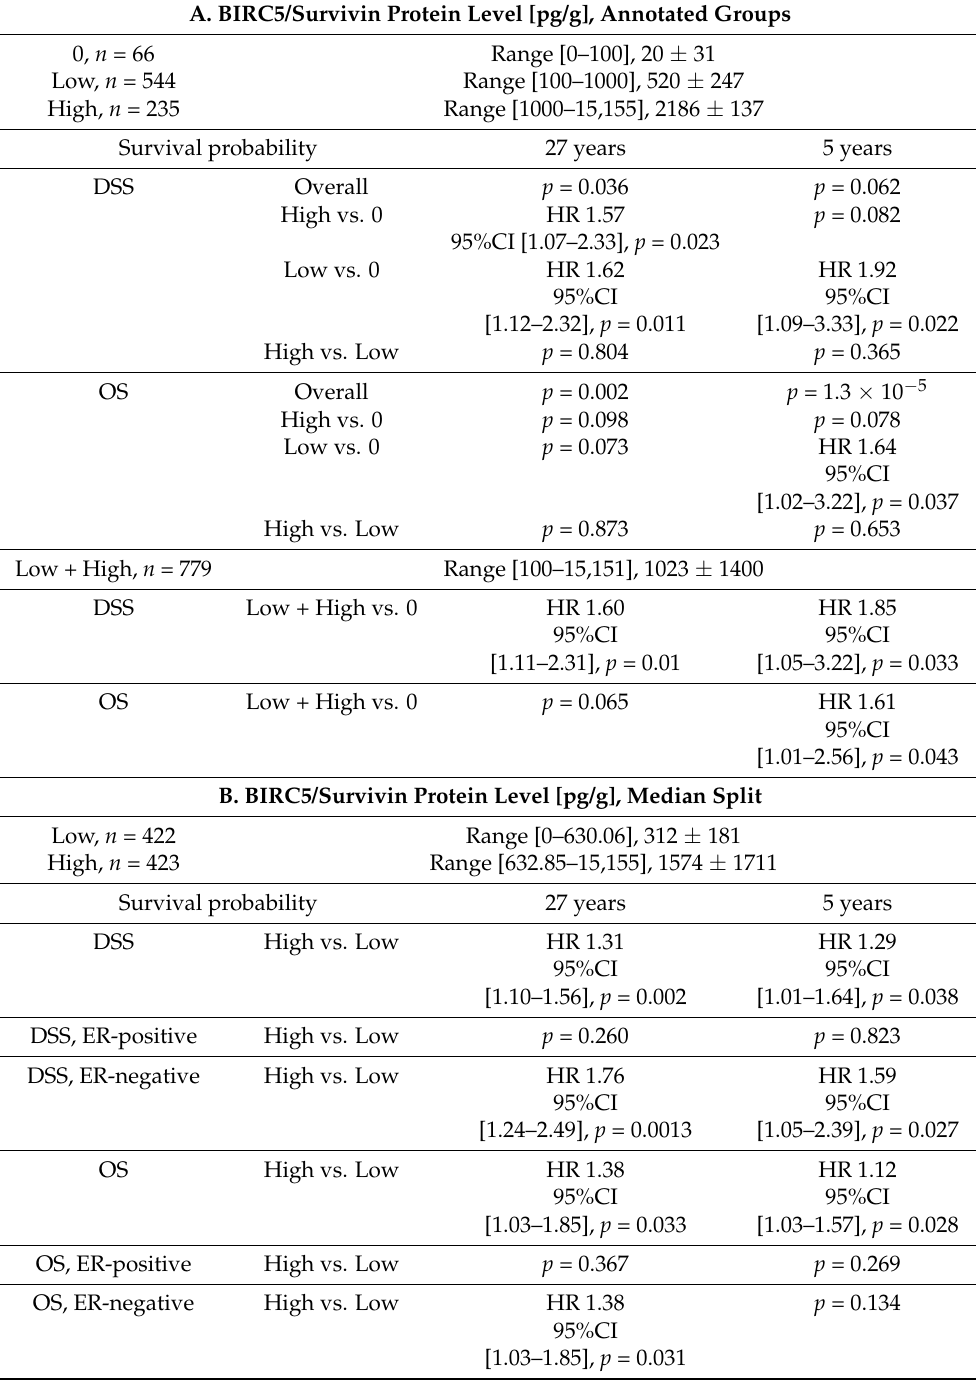
Table 2. Overall and disease-specific survival analysis for the VGR-BC cohort. A. BIRC5/Survivin Protein Level [pg/g], Annotated